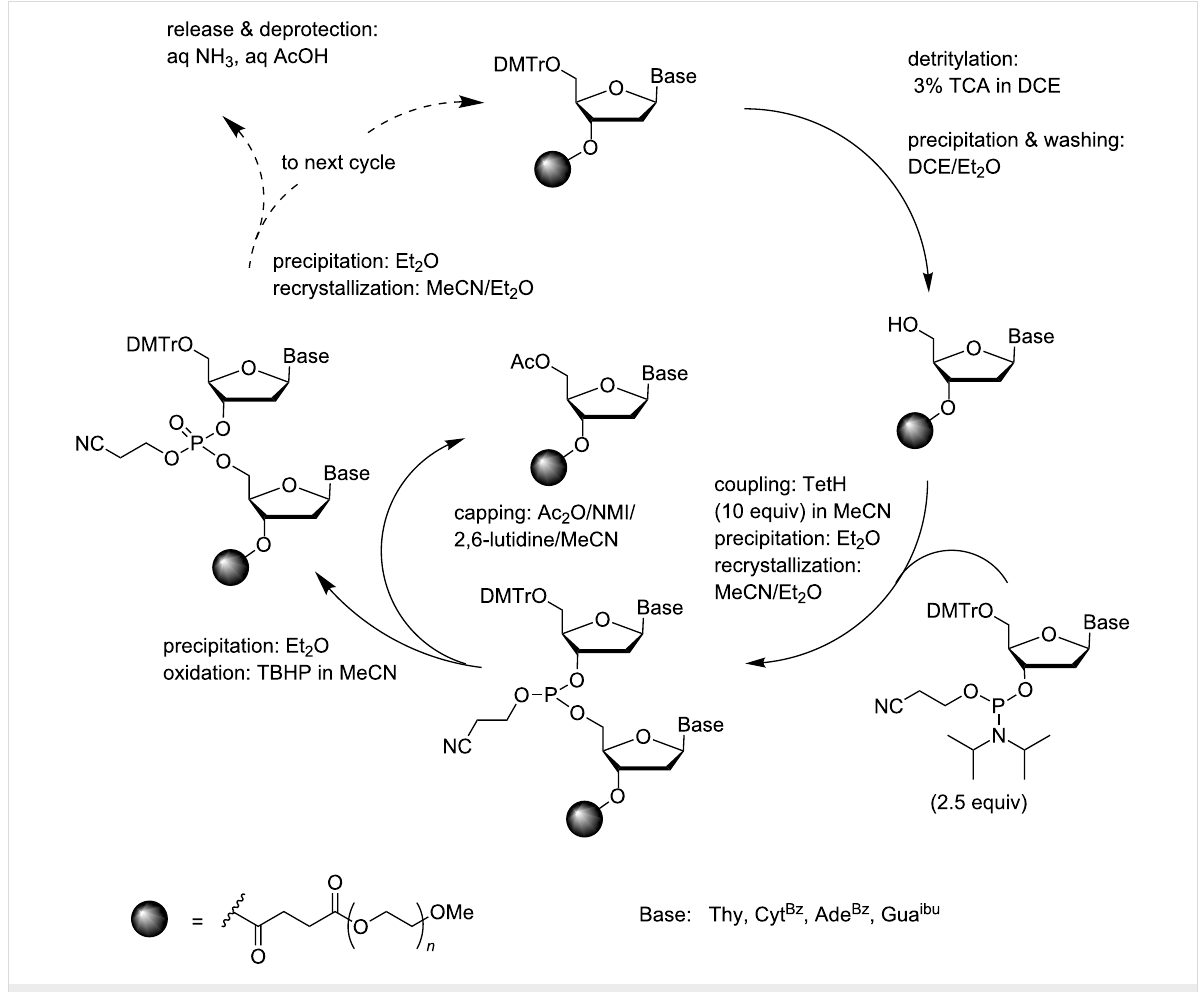
Scheme 4: Synthesis of ODNs on a precipitative PEG-support by conventional phosphoramidite chemistry